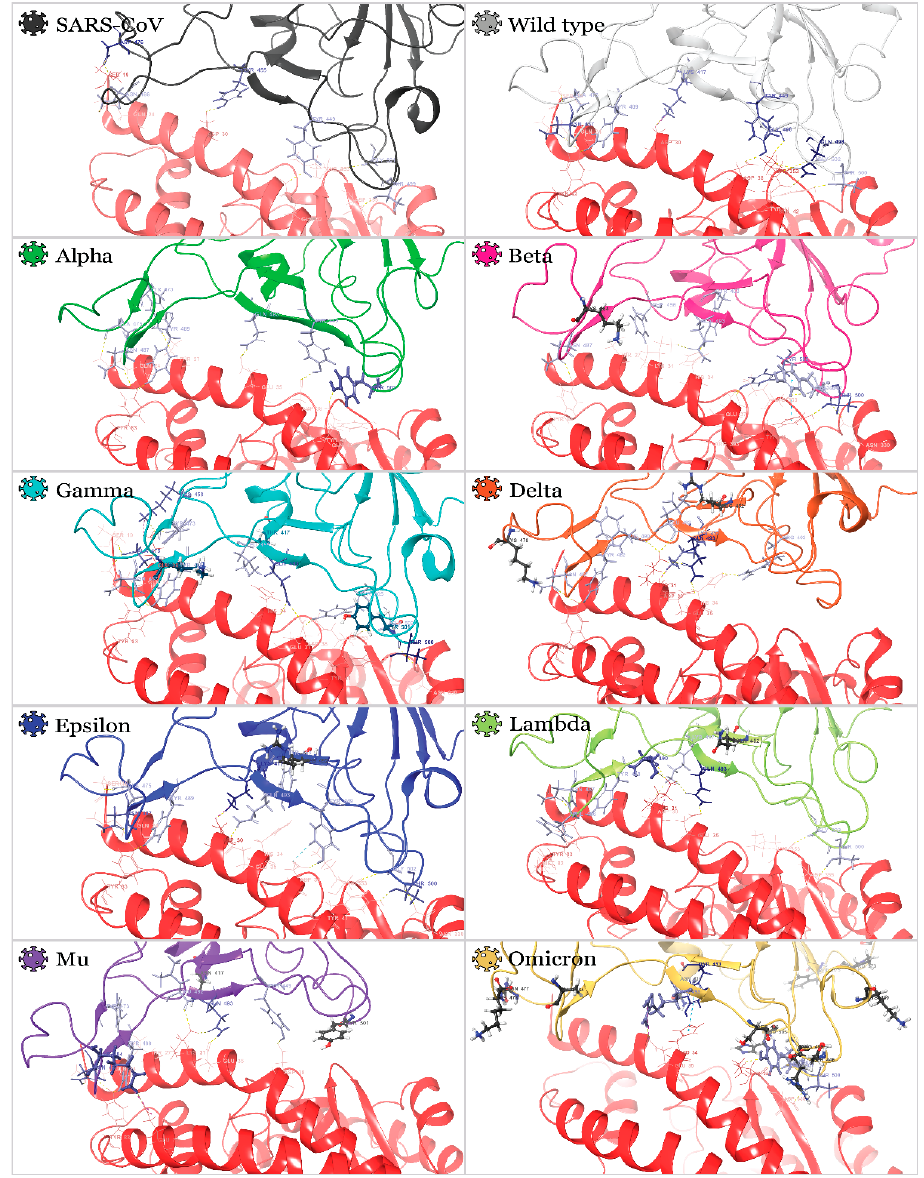
Figure 5. 3D structures of RBDACE2 complexes are represented by the most populated cluster derived from MD simulations: ACE2 residues, which participate in interactions with RBD, are illustrated with wire representation and are colored from pink to dark red in order of increased number of interactions. RBD residues, which participate in interactions with ACE2, are illustrated by thin tube representation and are colored from light blue to dark blue in order of increased number of interactions. Mutated residues are illustrated with ball-and-stick representation.